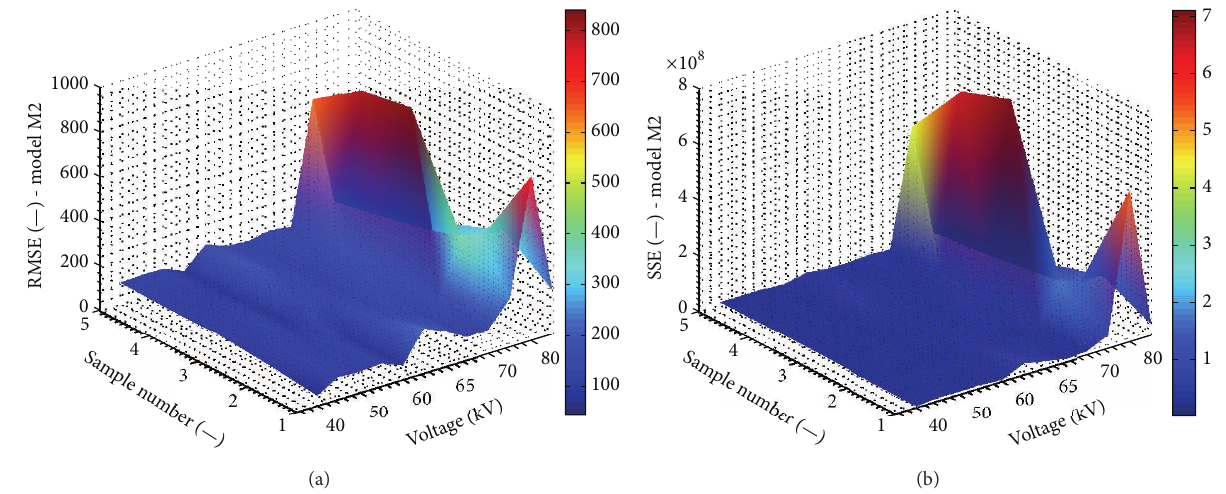
Figure 13: Comparison of RMSE (a) and SSE (b) obtained by regression of model M2 for all data samples.